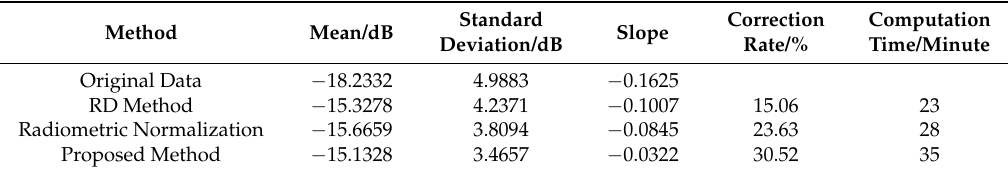
Table 4. The statistical significance of sample selection.